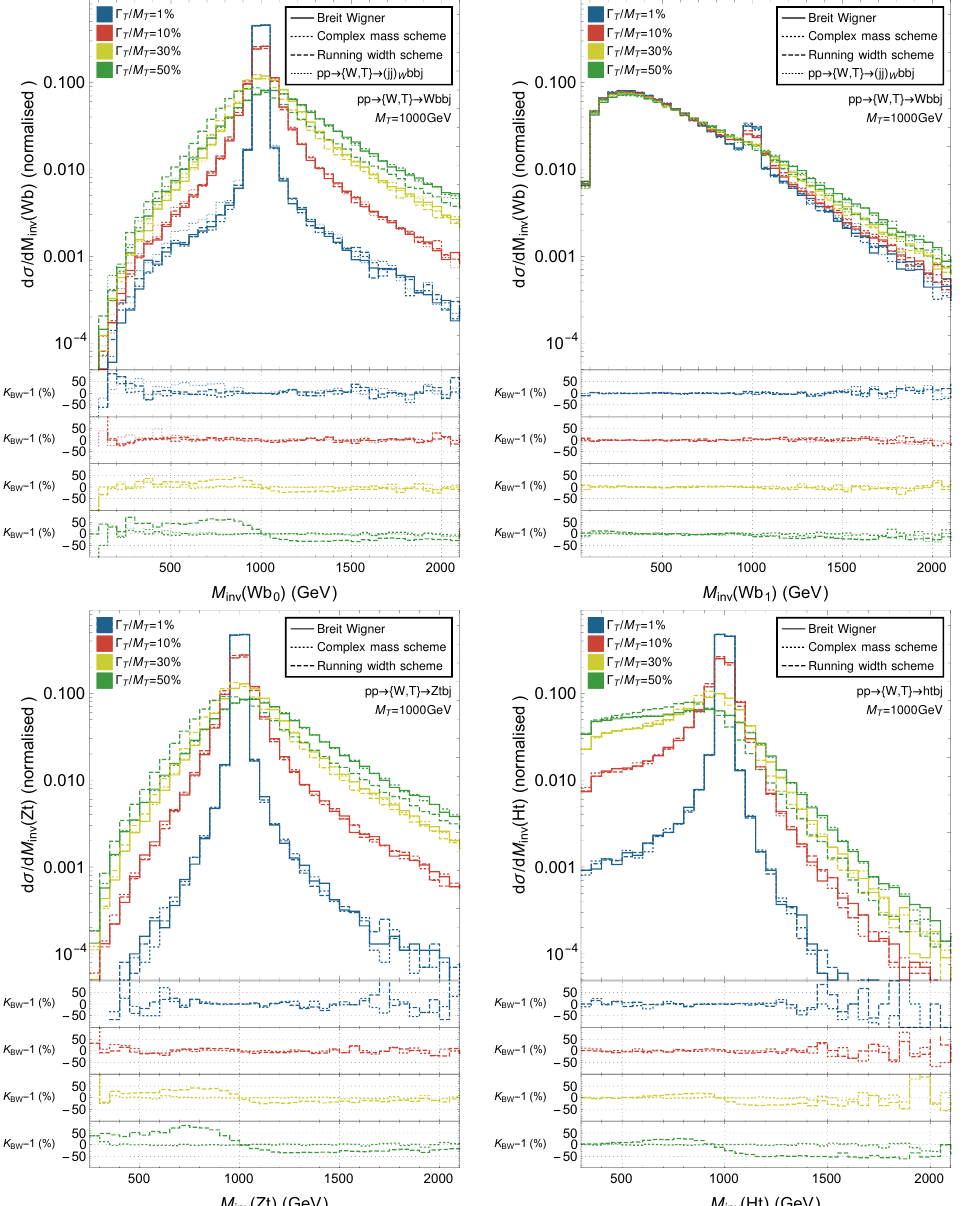
Figure 2 . Comparison between different schemes to treat the VLQ width, for scenarios featuring M T = 1000 GeV and for different processes: pp → { W, T } → Wbbj (first row), pp → { W, T } → Ztbj and pp → { W, T } → htbj (second row). For each plot the upper panel shows normalised VLQ invariant-mass distributions at parton level, for different schemes and for different width-over-mass ratios. The lower panels provide the ratio between each scheme and the Breit-Wigner (BW) scheme, (%) . For the process pp → { W, T } → Wbbj two distributions are considered. K BW − 1 = scheme − BW BW They correspond to considering the leading b -jet (upper left) or the sub-leading b -jet (upper right) as part of the T decay products. Still, only for the Wbbj final state, the process in which the W -boson decays into jets is also considered (in the complex mass scheme), and the W -boson is there reconstructed from the pair of final-state light jets. For analogous results for T production via Zt interactions, we refer to figure 19 in appendix